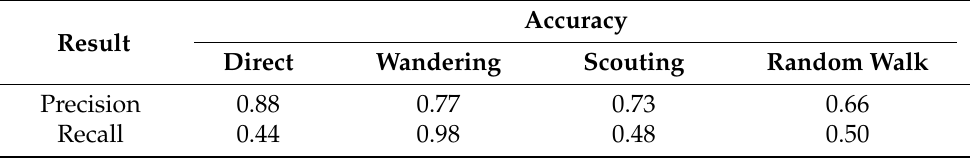
Table 2. Identification results of mobility behavior patterns for a single